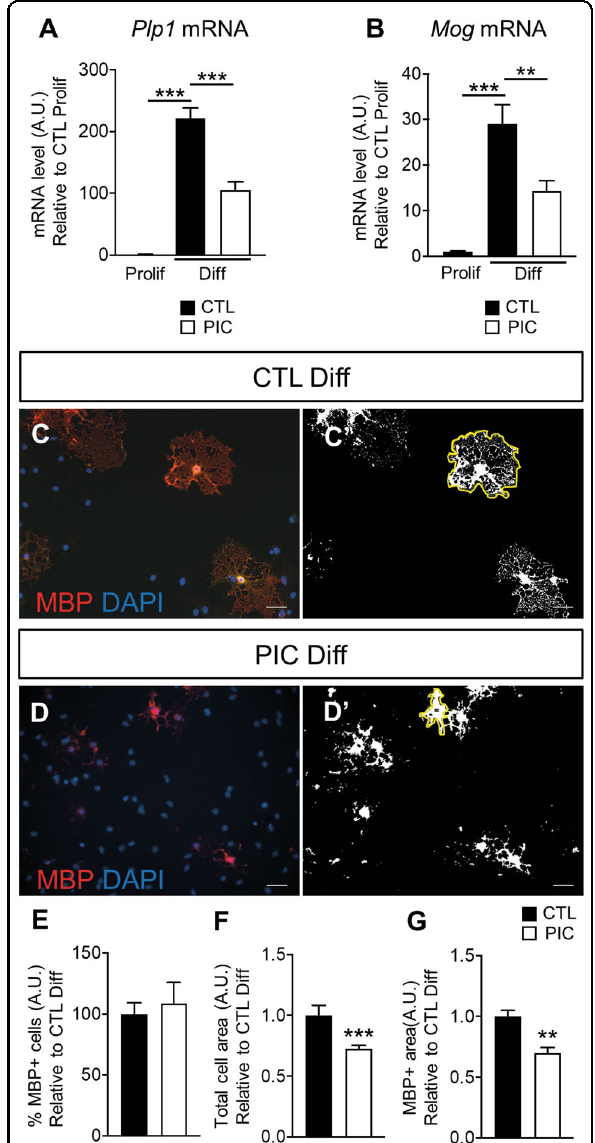
Fig. 6 Poly(I:C) treatment during differentiation results in downregulation of myelin genes and defects in reaching the more mature phenotype. A – B qPCR analysis of Mbp and Plp1 in primary OLs treated with Poly(I:C) (PIC) 50 ug/ml for 72 h in differentiation (Diff) medium (results are the mean of four independent experiments performed in triplicate ±SEM, ** P < 0.01, *** P < 0.001 One-way Anova followed by Bonferroni ’ s multiple comparison test). C – D ’ Immuno fl uorescent staining for MBP. To evaluate MBP morphology coloured images ( C , D ) have been transformed in binary with ImageJ ( C ’ , D ’ ). E – G Histograms reported the percentage of MBP + cells ( E ), measure of the cell area ( F , delimited with yellow line in C ’ and D ) or of the area covered by MBP immunostaining ( G , white signal in C ’ and D ’ ; data are mean ± SEM, n = 9 coverslips for each condition from three independent experiments, ** P < 0.01, *** P < 0.001 Unpaired t -test). Scale bar 100 μ